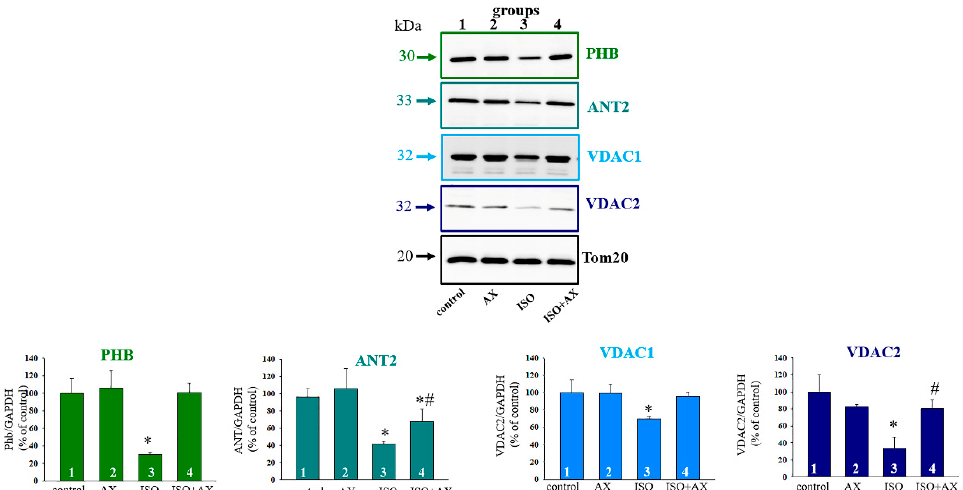
Figure 4. Effects of the administration of AX on the content of PHB, ANT2, VDAC1, and VDAC2 in rat heart mitochondria in heart failure. Upper part—immunostaining with PHB, ANT2, VDAC1, VDAC2, and Tom20 antibodies; Low part— quantification of immunostaining by computer-assisted densitometry presented as a ratio of proteins to Tom20. Bar graphs represent the levels of appropriate proteins; the data are presented as the means ±SD of three independent experiments. * p < 0.05 significant difference in the protein level in comparison with the control (group 1). # p < 0.05 compared to RHM isolated from ISO-injected rats (group 3). The statistical significance of the differences between the pairs of mean values was evaluated using the Student-Newman-Keul test.